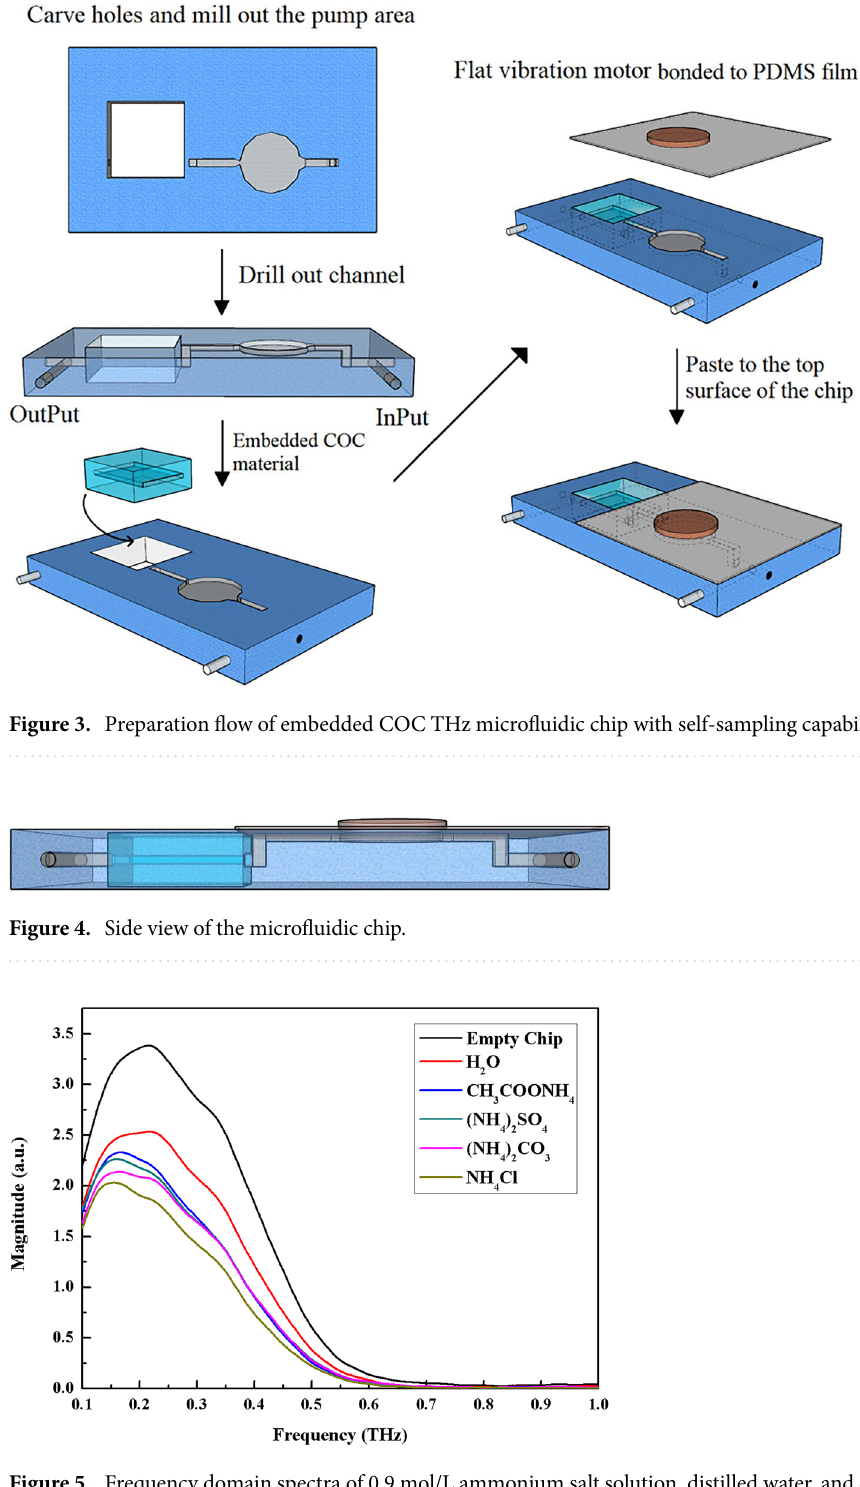
Figure 5. Frequency domain spectra of 0.9 mol/L ammonium salt solution, distilled water, and empty